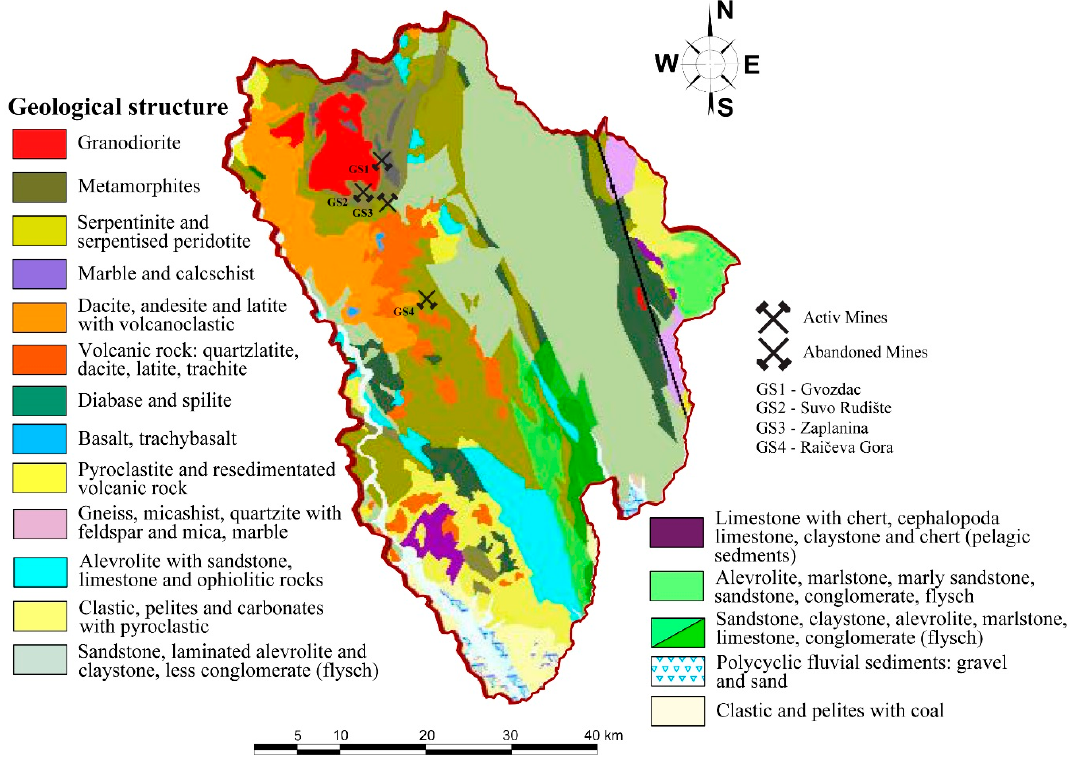
Figure 3. Geological structure Kopaonik area [66].